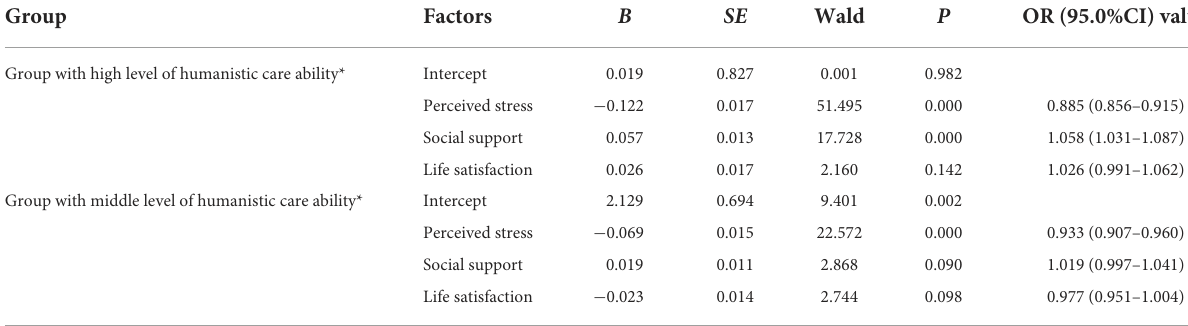
TABLE 2 The multivariate logistic regression analysis of the factors affecting humanistic care ability. Group